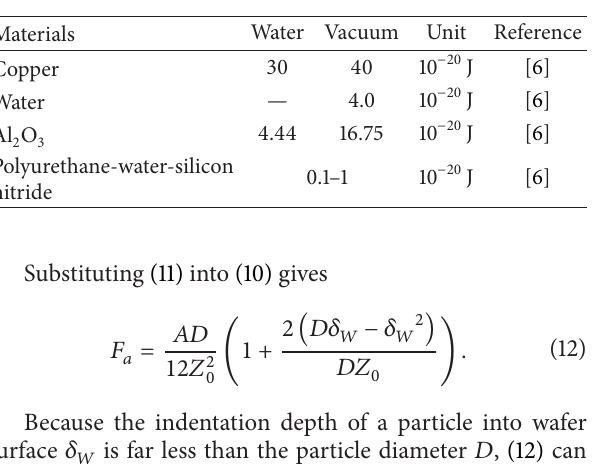
Figure 4: Adhesion force considering particle deformation. Table 1: Hamaker constant of Cu-Water-Al